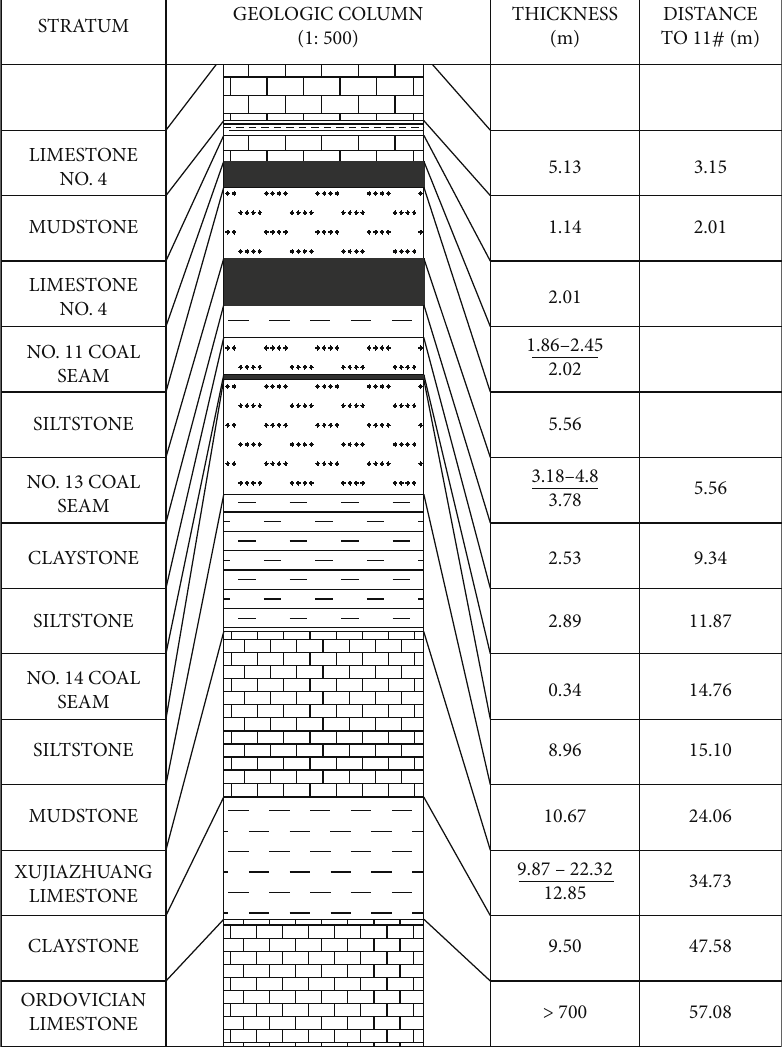
Figure 1: Comprehensive histogram of the fi rst mining area of the research mining